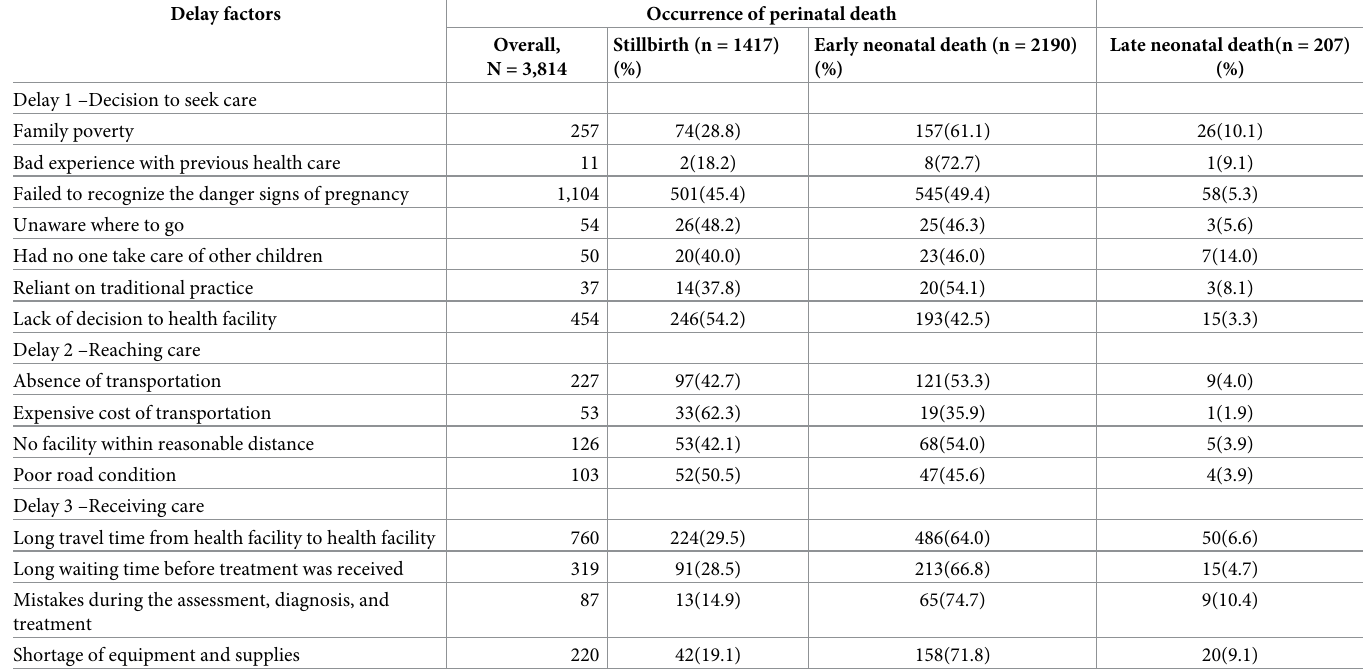
Table 8. Delay factors contribute to perinatal death by the timing of death in